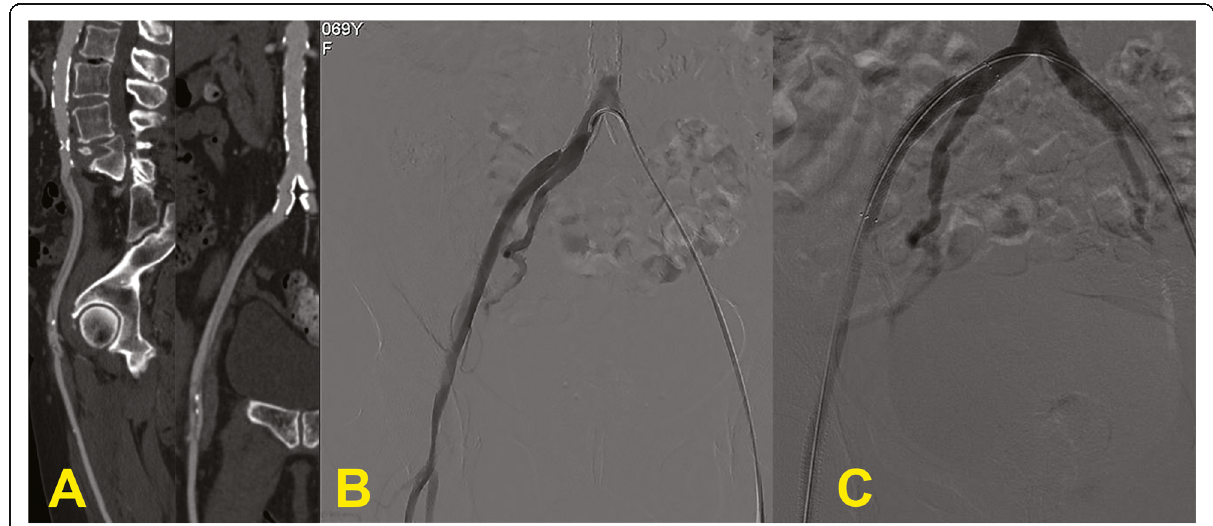
Fig. 3 a-c Dissection. Sagittal and coronal CT reformats ( a ) show dissection of the whole iliac axis extending up to the common femoral artery. Angiography with crossover approach ( b ) confirms the dissection with iliac stenosis proximally to the femoral bifurcation. The dissection has been treated with the placement of two stents; angiography after treatment ( c ) demonstrates restoration of regular patency of iliac and common femoral